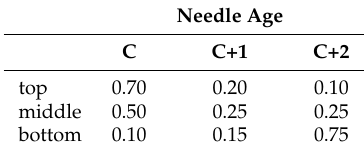
Table A3. Weighting factors used to compute average leaf optical properties for crown vertical